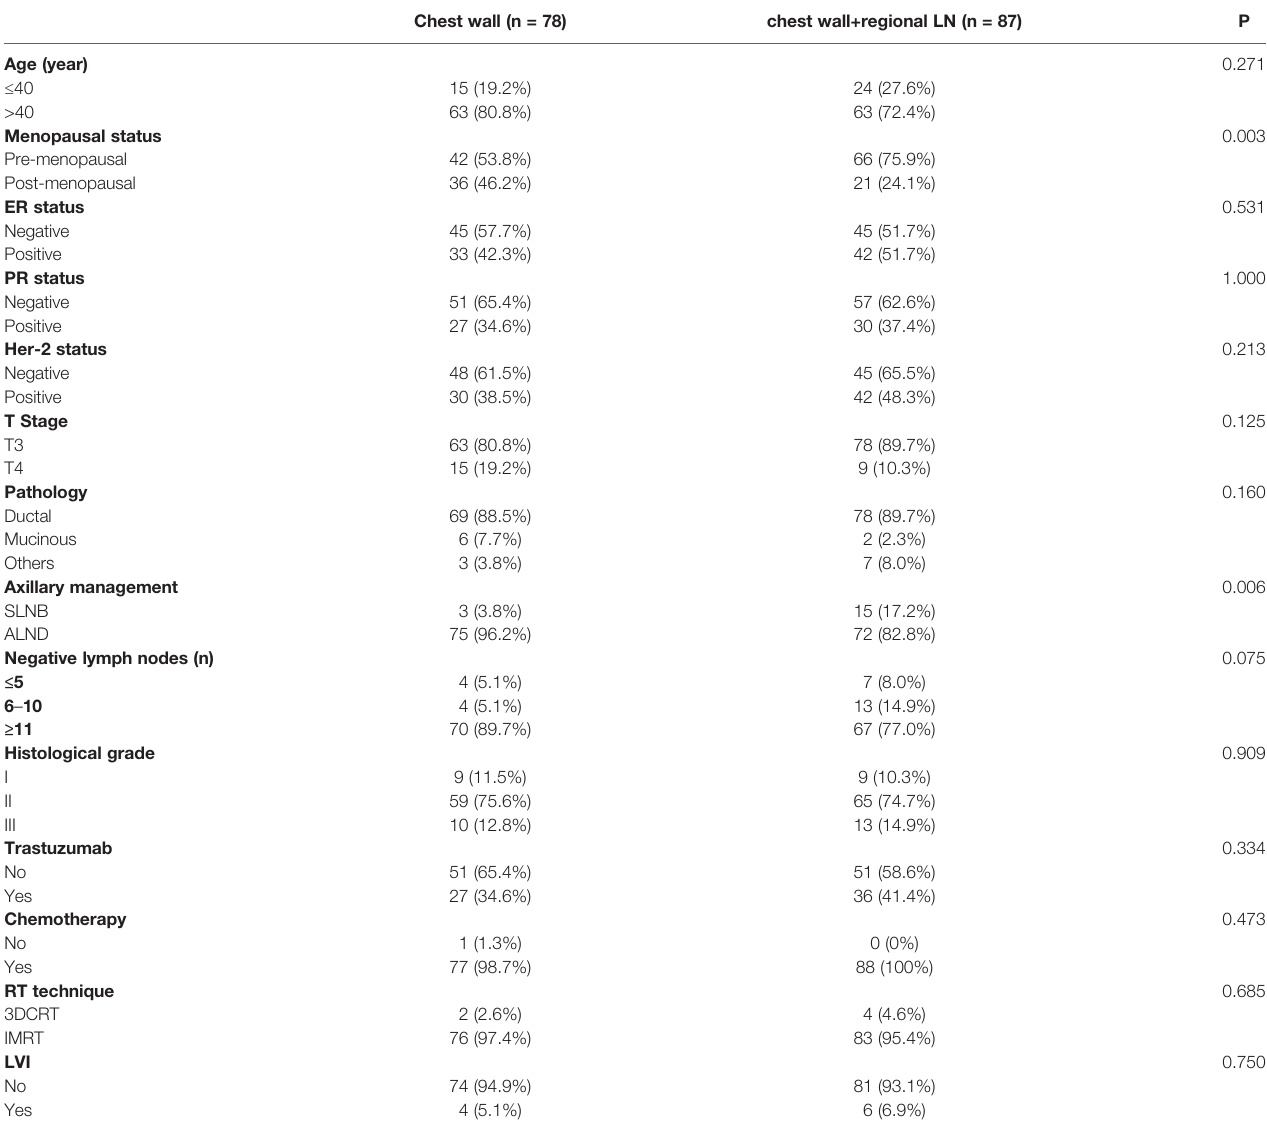
TABLE 1 | Baseline characteristics and treatment patterns for chest wall ± regional LN